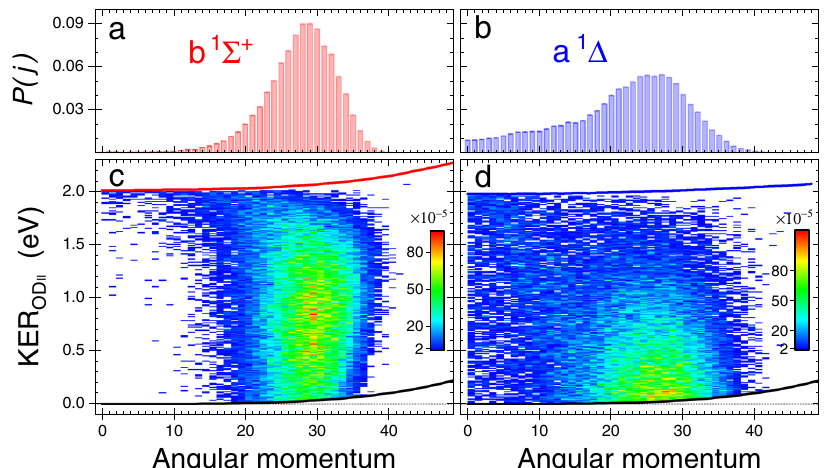
momentumbytheadditionofacentrifugalpotentialtoboththesingletandtriplet potentialcurves(speci fi cally,A 3 Π -black,b 1 Σ + -red,anda 1 Δ -blue).Intheabsence correla- of tunneling no dissociating trajectories can appear outside these lines. Source II data are provided as a Source Data fi le.